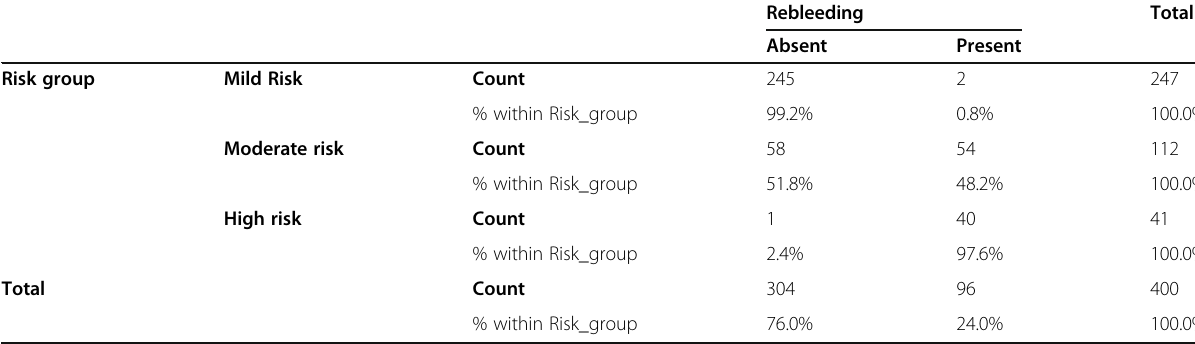
Table 5 Variceal rebleeding distribution in accordance to a risk score of the proposed